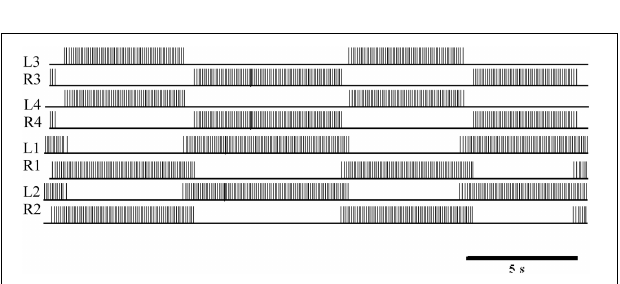
FIGURE 6 | Logic analyzer measurements of the digital eight-neuron CPG. L3 and R3 show the activity of the first oscillator. L4 and R4 show the activity of the second oscillator. L1/R1 and L2/R2 are the coordination neurons.